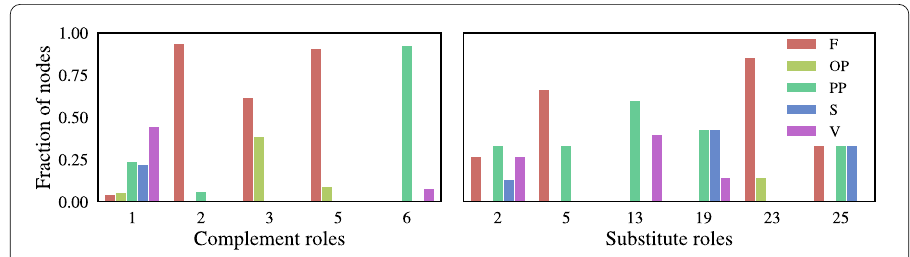
Figure 10 Proportion of the products in typical complement roles ( left ) and typical substitute roles ( right ) that fall in each L3 category, fruit (F), organic produce (OP), prepared produce (PP), salad (S) and vegetable